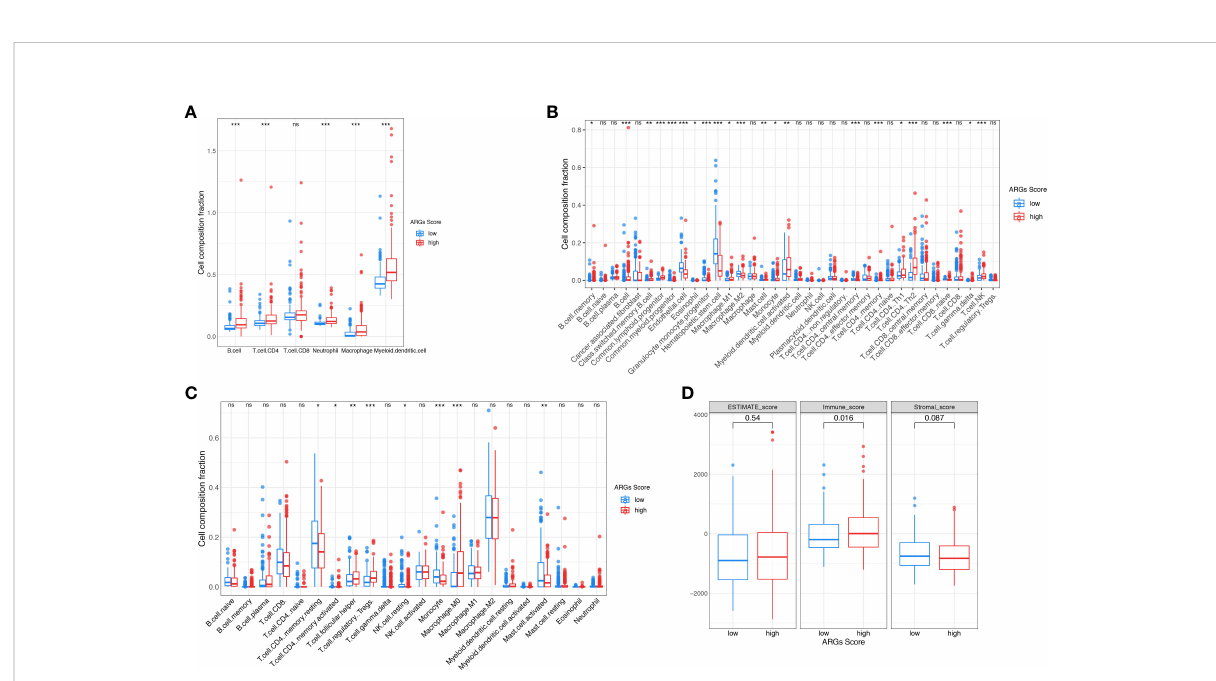
FIGURE 9 The landscape of tumor immune microenvironment. The composition of tumor in fi ltration immune cells was compared between high-score and low-score groups based on the TIMER (A) , CIBERSORT (B) and xCell (C) . (D) Stromal score, Immune score and ESTIMATE score between high-score and low-score groups in TCGA. *p< 0.05; **p< 0.01; ***p< 0.001. ns, not signi fi